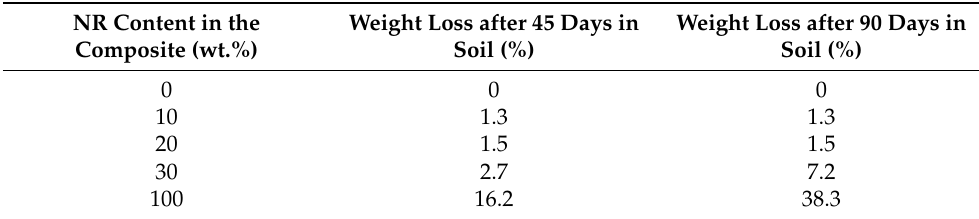
Table 2. Change in weight of polyethylene/natural rubber composites after exposure to soil. Adapted from Mastalygina Elena et al. [52].